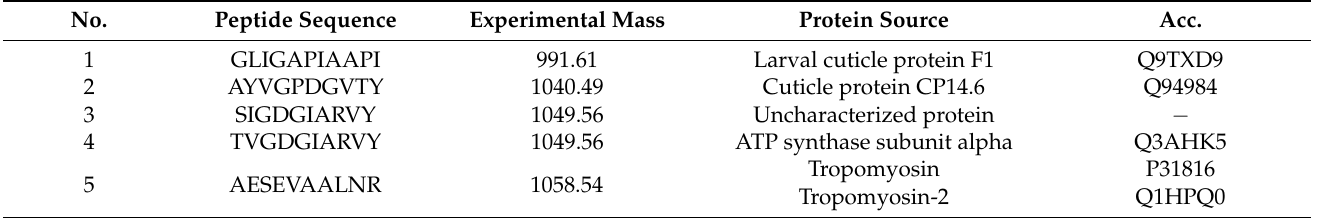
Table 1. Amino acid sequences of peptides from raw larvae flour hydrolysate determined by nLC- MS/MS with a molecular weight <1.5 kDa and minimum 50% of hydrophobic amino